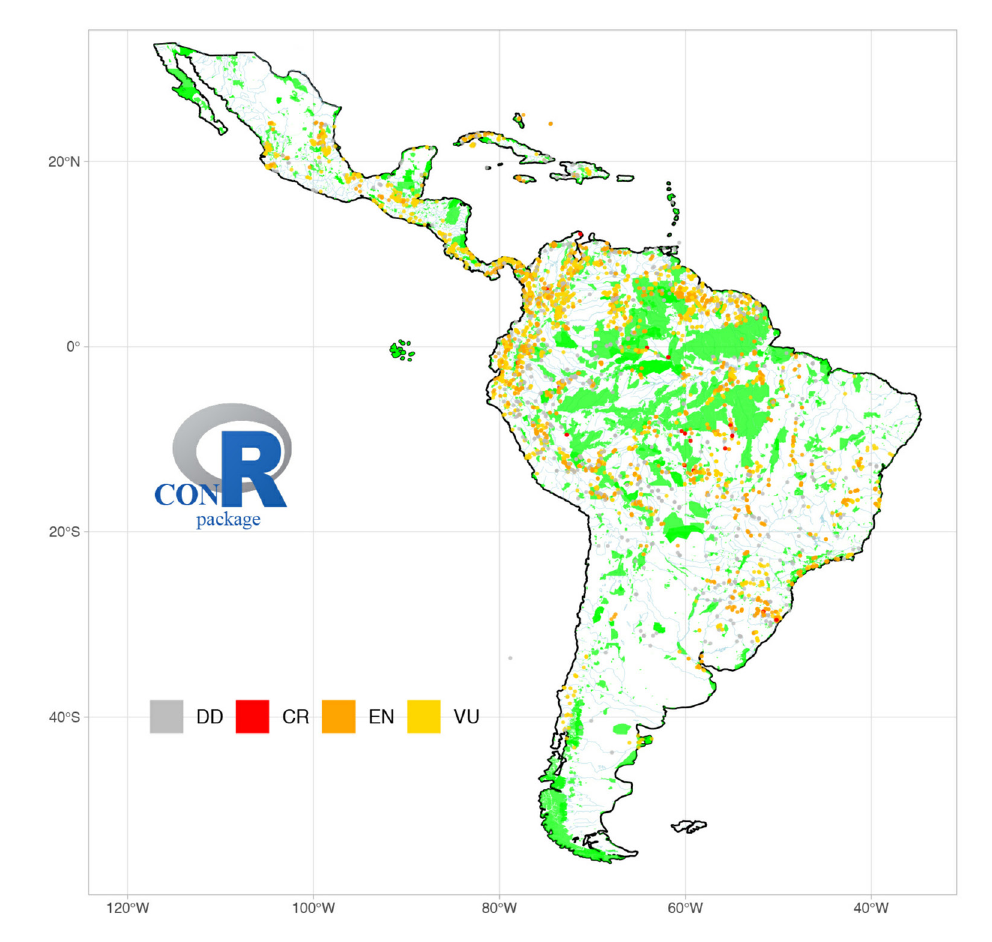
FIGURE 6 | Collection points for 671 potentially threatened Neotropical Freshwater Fishes (NFF). Potentially threatened NFF species predicted by the ConR package using EOO estimates are usually distributed outside protected areas ( e.g ., national parks, indigenous lands: green) and more often located in the upland rivers of the northern, central and southern Andes, and Eastern Guiana Shield. CR: Critically Endangered; EN: Endangered; VU: Vulnerable; LC or NT: Least Concern or Near Threatened; DD: Data Deficient. Data for 4,412 localities with geographic coordinates. Protected areas (green) from: